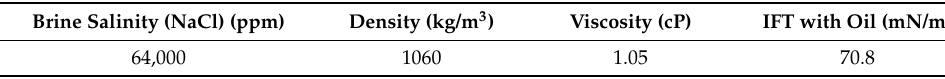
Table 2. Composition and properties of brine.